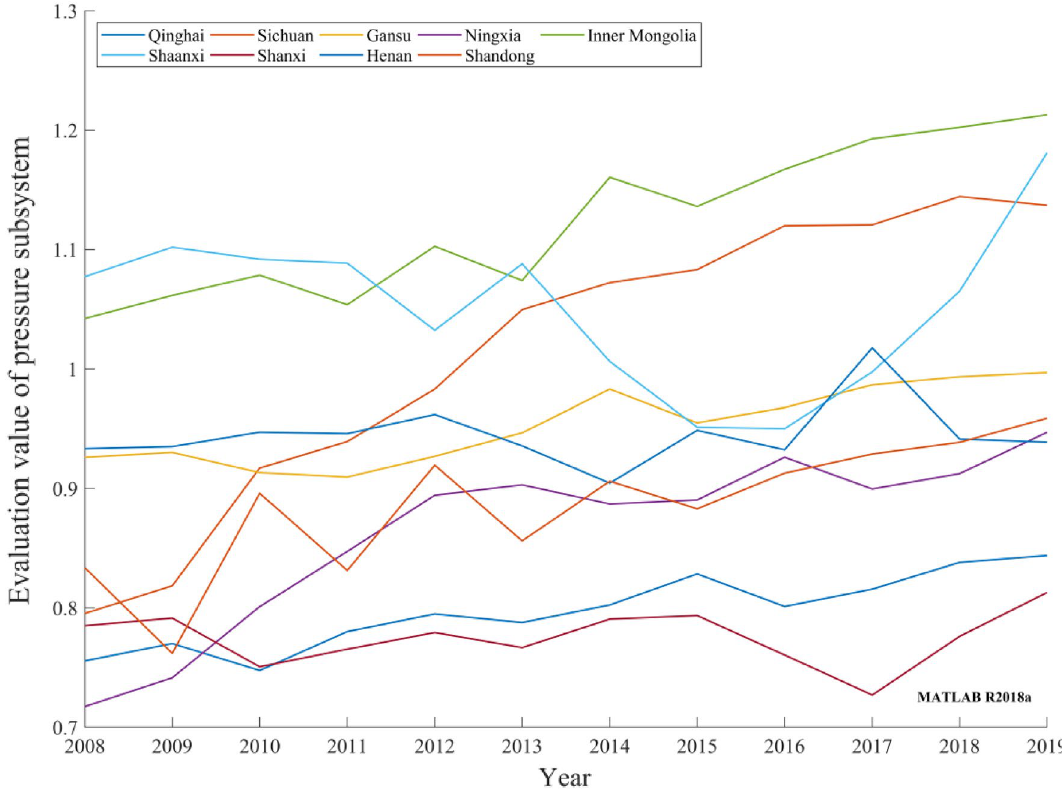
Figure 4. Evaluation values of provincial carbon-neutral pressure subsystems in the Yellow River basin during